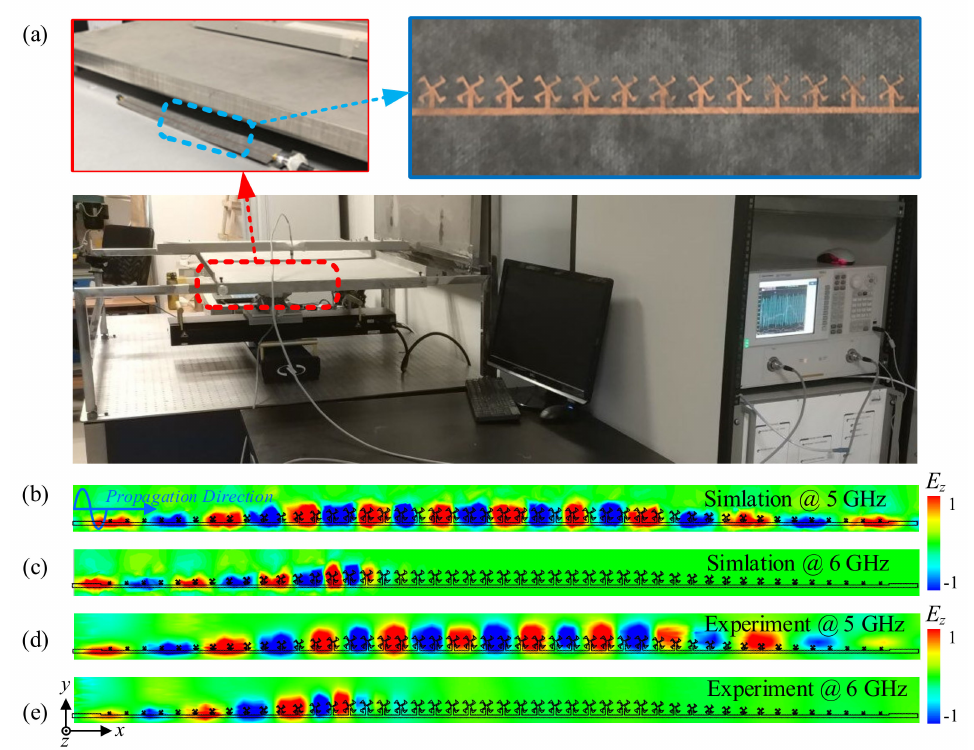
Figure 7. Homemade microwave near-field scanning system and the field distributions of the microwave SSPP waveguide. ( a ) Photograph of the homemade microwave near-field scanning system; ( b – e ) simulated and measured electric field E z distributions of the microwave windmill- shaped SSPP waveguide on the xoy plane at z = 1 mm at 5 GHz and 6 GHz, respectively.